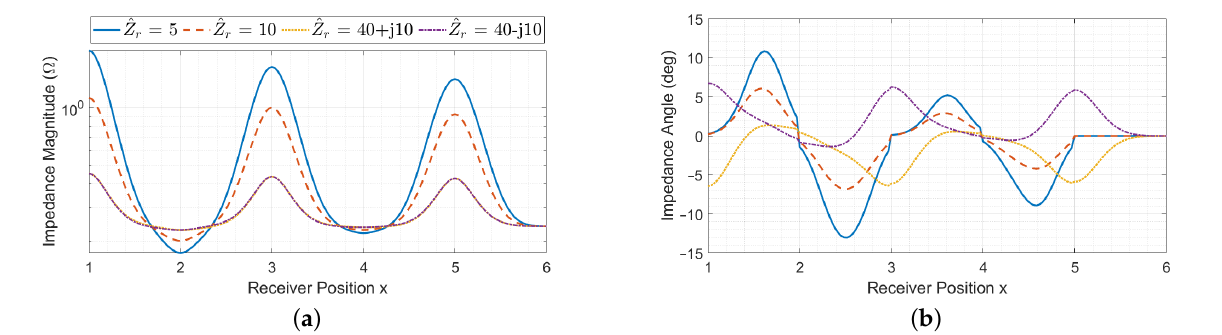
Figure 9. Array input impedance as a function of the receiver position with open-circuit termination for different values of the receiver impedance ˆ Z r , in magnitude ( a ) and phase ( b